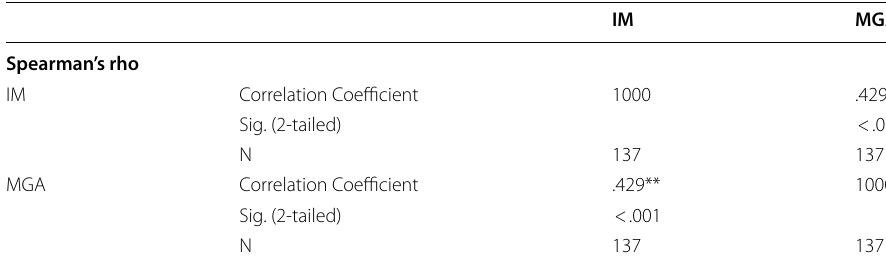
**Correlation is significant at the 0.01 level (2-tailed)